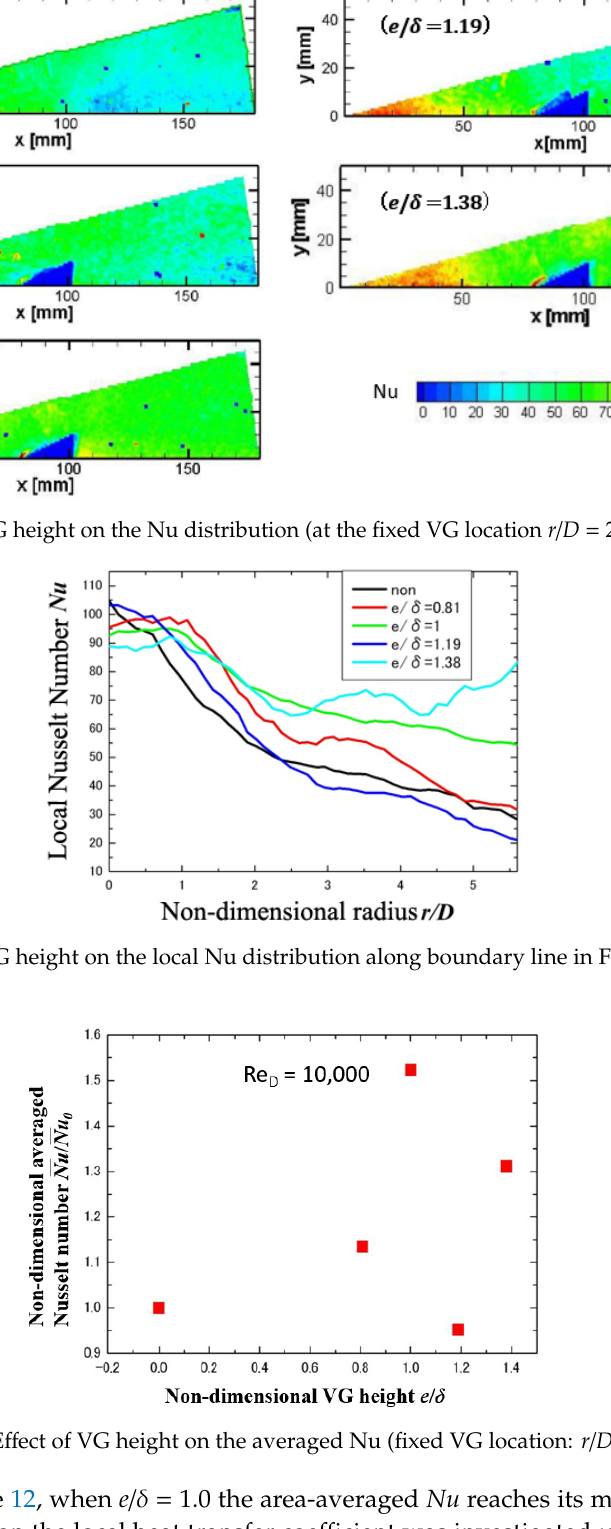
Figure 12. Effect of VG height on the averaged Nu (fixed VG location: r / D = 2.5).